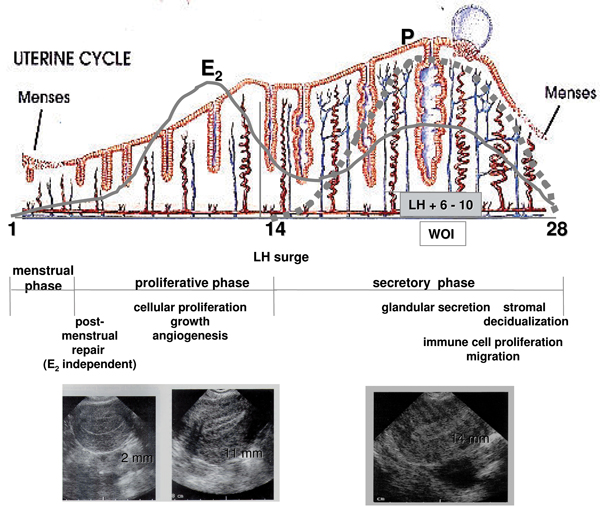
Cyclic changes in endometrium across the cycle. Shown are hormonal profiles, cycle phases and sub-stages, and ultrasonographic appearance of the endometrium in early proliferative, late proliferative, and mid-secretory phases. Reproduced with permission of Adeza Biomedical.